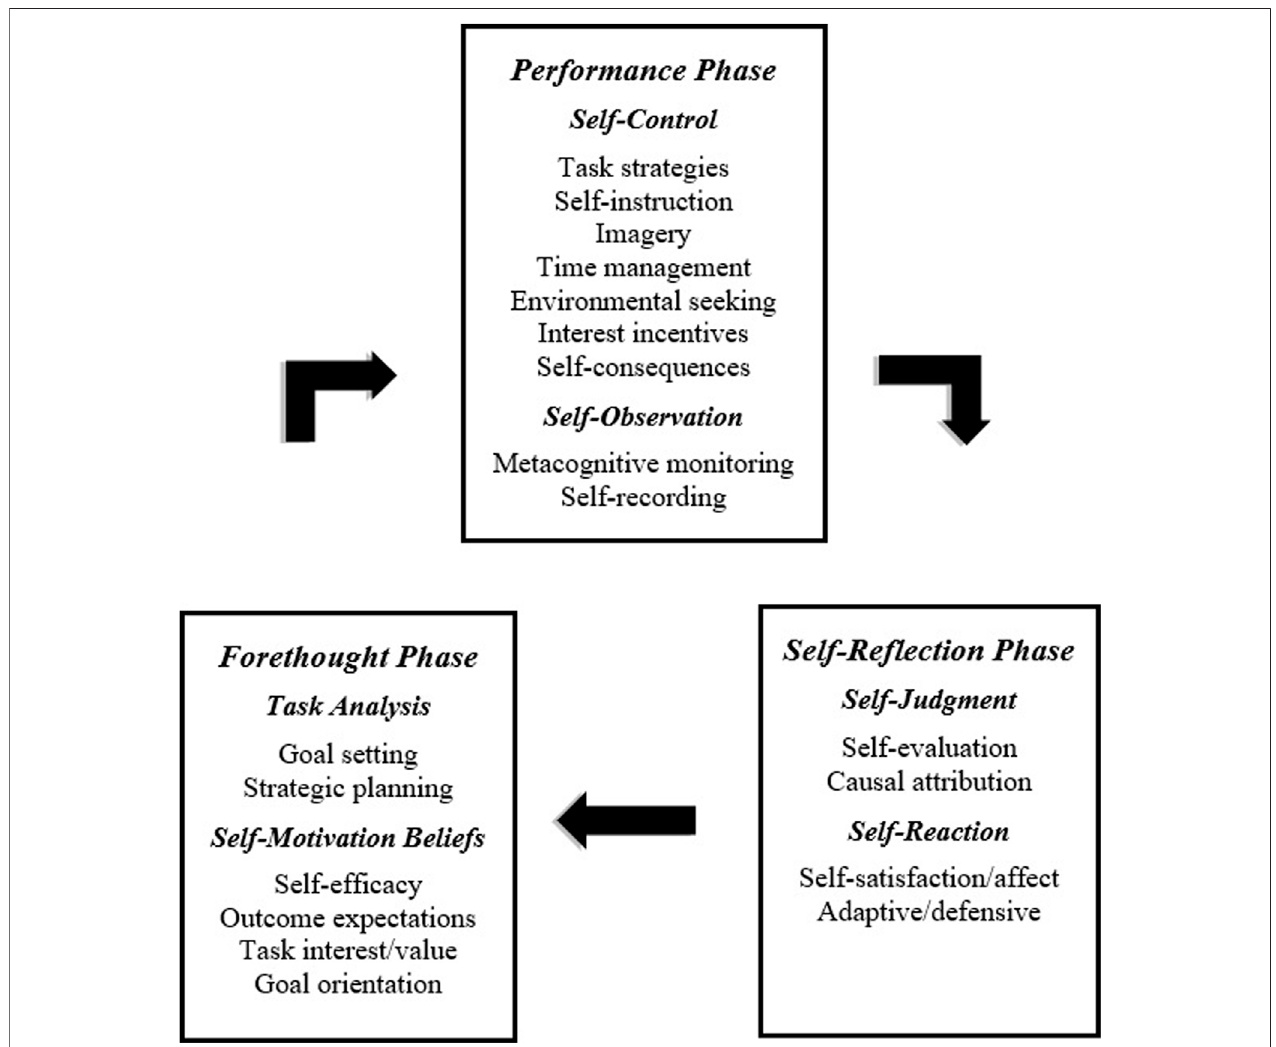
FIGURE 2 | Zimmerman and Moylan ’ s (2009) self-regulated learning